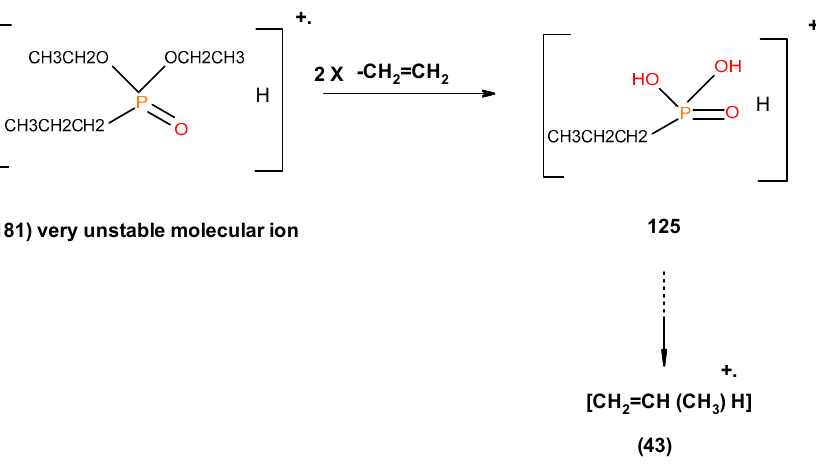
Figure 13. Possible fragmentation pattern of